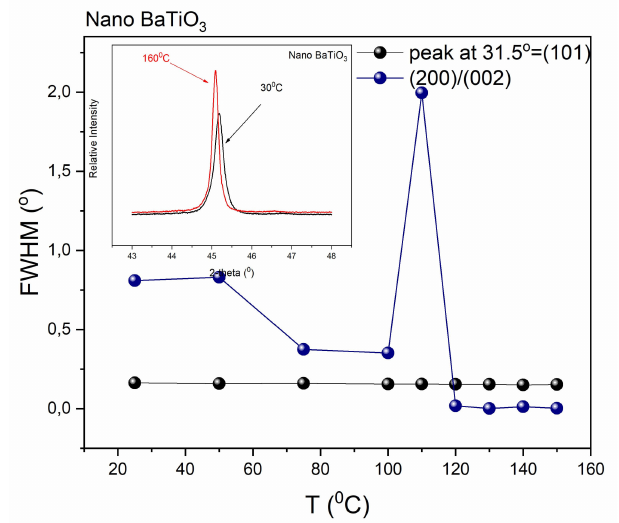
Figure 6. FWHM as a function of temperature for the di ff raction peak at 31.5 ◦ (101) and for the FWHM ratio of (200) / (002) di ff raction peaks. Inset shows the XRD patterns of nano-BT particles at 30 ◦ C and 160 ◦ C respectively. Lines are visual